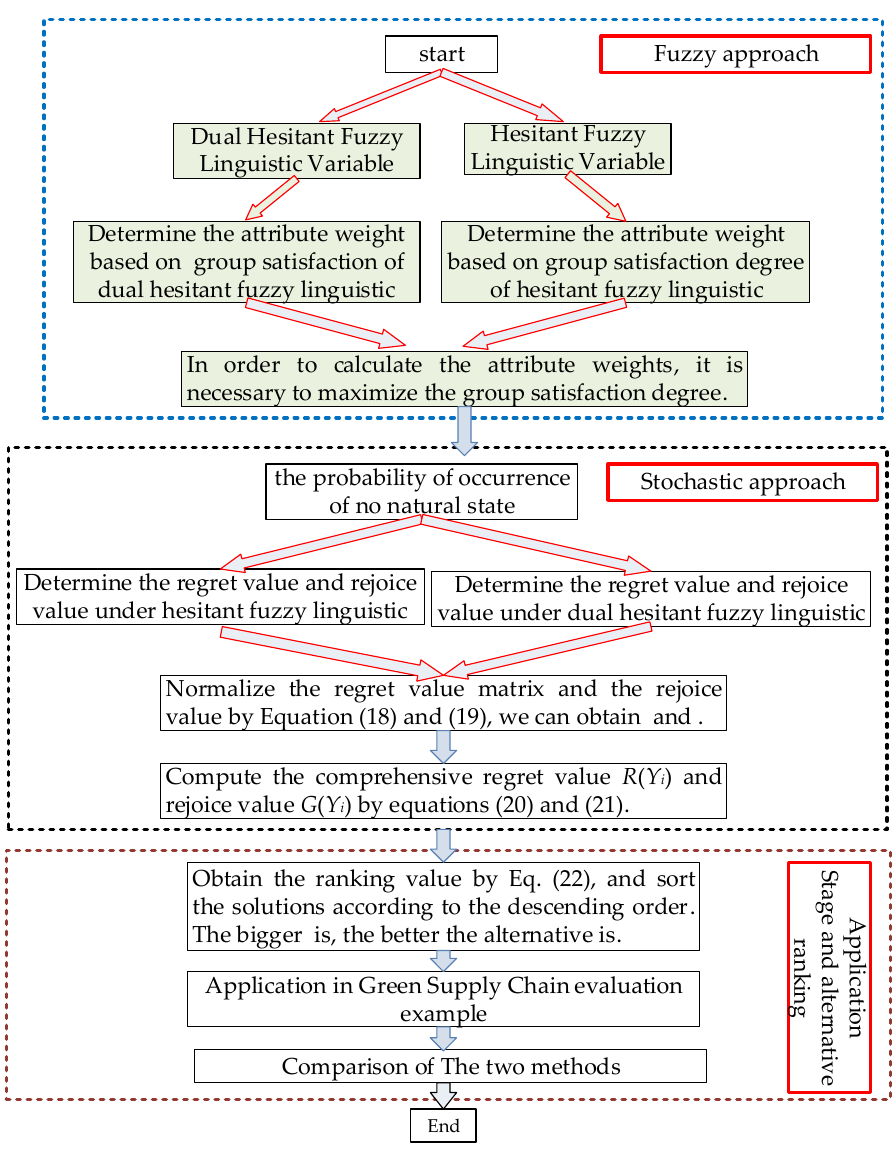
Figure 1. The schematic diagram of the proposed approach for DHFLSMADM.